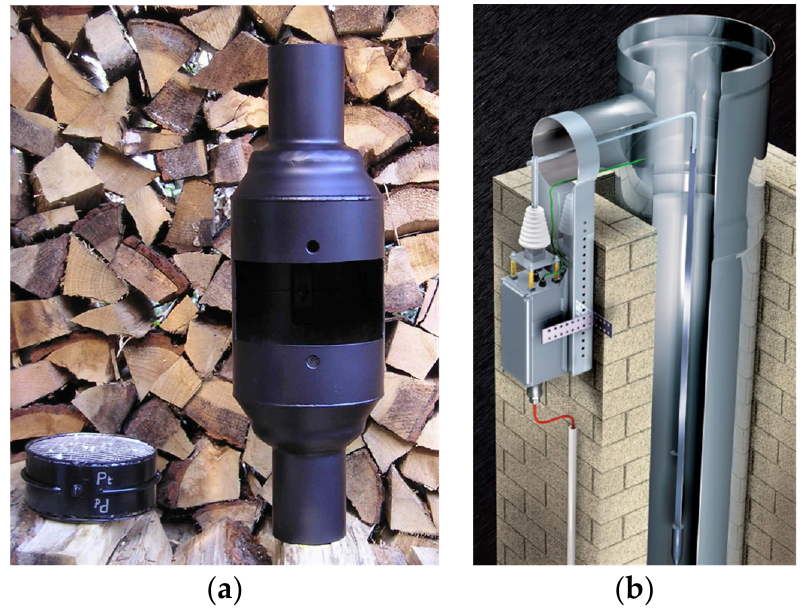
Figure 1. Pollution control devices tested in the chimneys of a woodstove and a pellet stove: ( a ) platinum/palladium catalyst and ( b ) small-scale electrostatic precipitator. A commercial chimney-top tubular electrostatic precipitator (OekoTube) with manual electrode cleaning was selected for the combustion experiments. The ESP, developed by Oekosolve, has a power consumption of 20–30 W during operation and a high-voltage power applied in the range of 15–30 kV. The precipitation electrode was inserted into the chimney and the control system and electronic circuit were installed outside (Figure